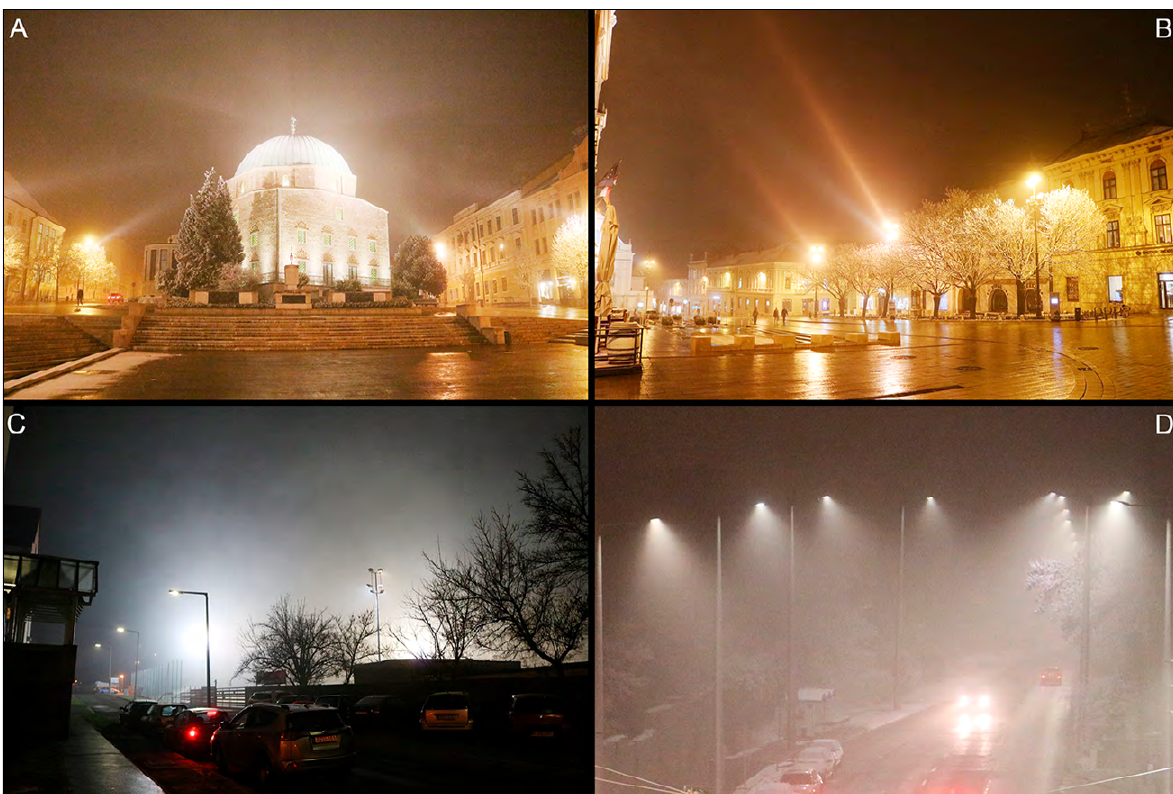
Figure 4. Negative and positive examples of lighting in Pécs (2019). The photos were taken in fog. Ornamental lighting and the reflectors of the stadium are largely directed above the horizon (A, B, C), while the new LED lamps fully below the horizon